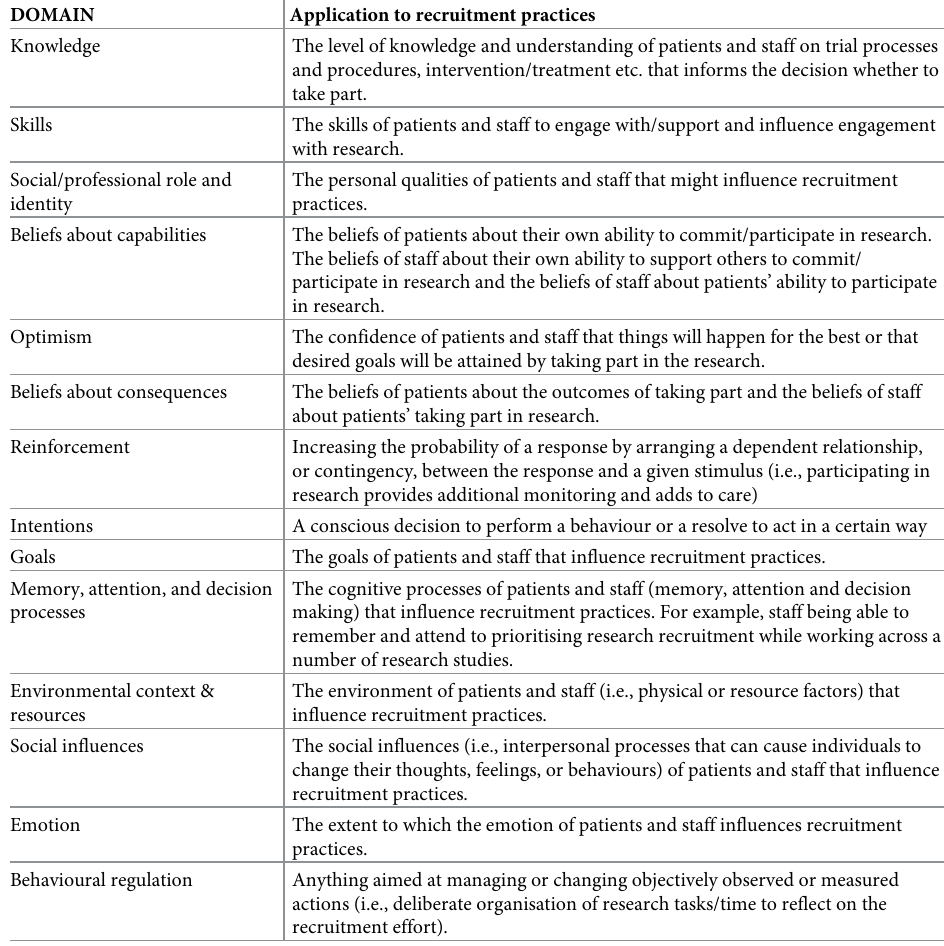
Table 1. The theoretical domains framework and example application to